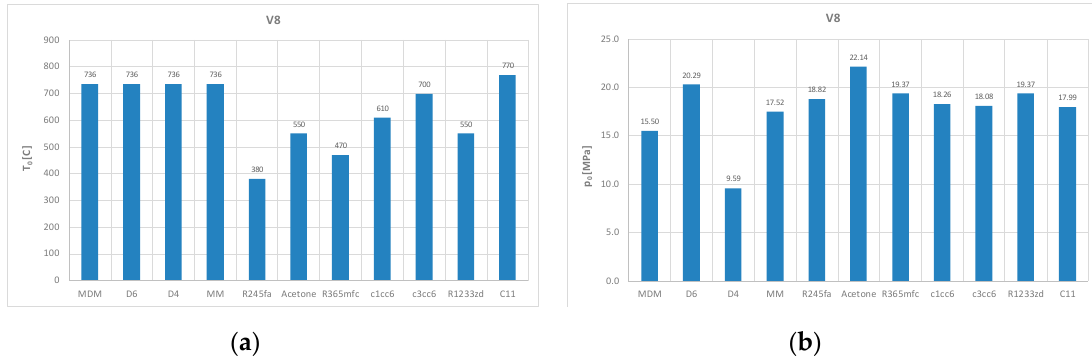
Figure 10. Values of temperature ( a ) and pressure ( b ) of live vapor optimized for different working media (Variant 8).